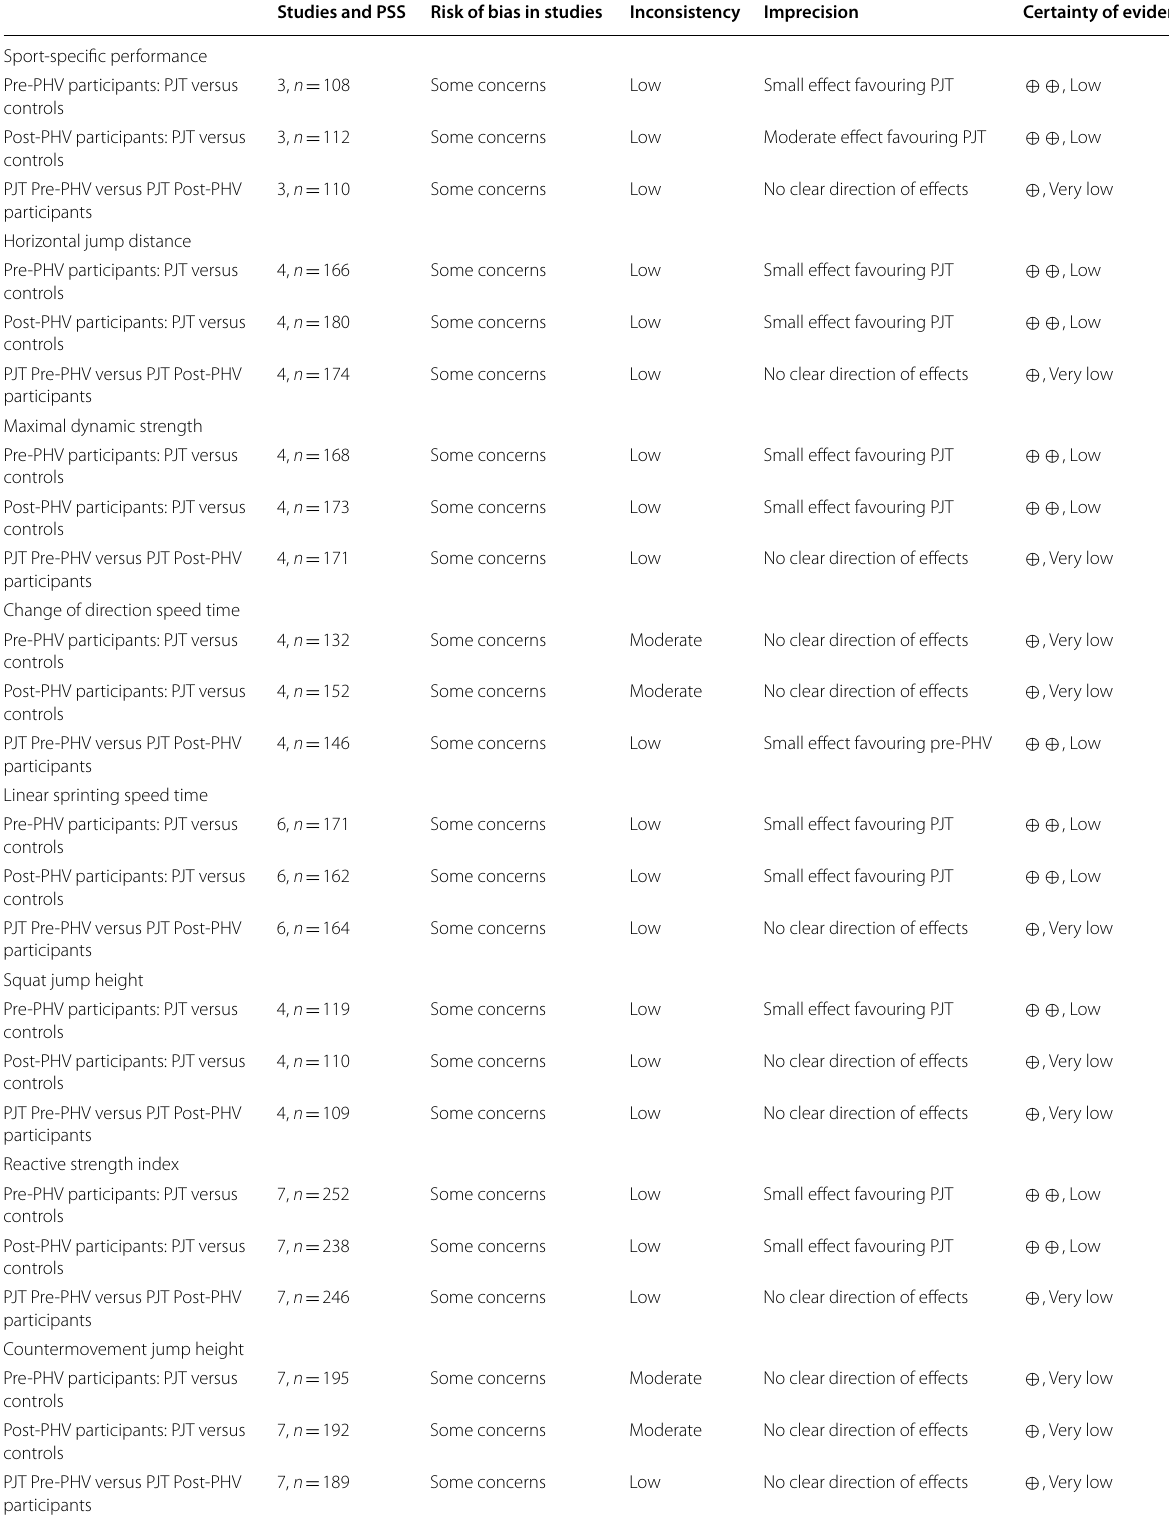
Table 6 GRADE analyses Studies and PSS Risk of bias in studies Inconsistency Imprecision Certainty of